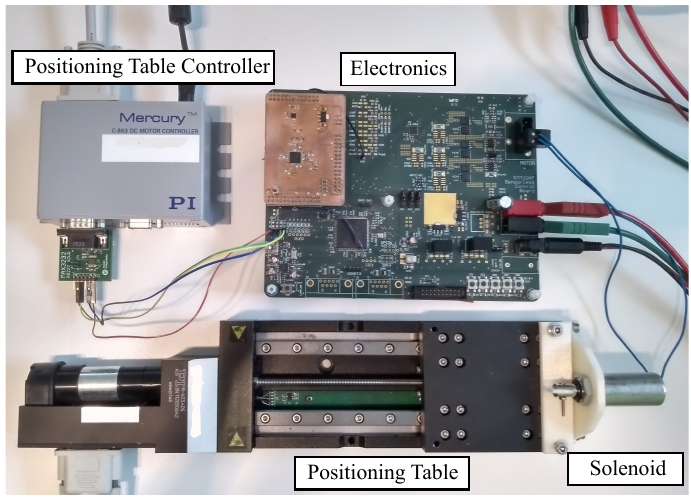
Figure 11. Test-bench used for characterization and validation of the solenoid actuator, including linear positioning stage, dedicated electronics as well as solenoid actuator under